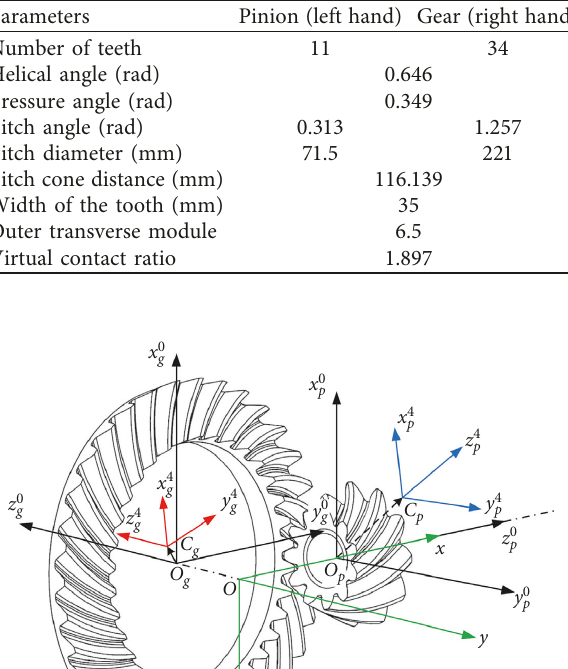
Table 1: Design parameters of the example spiral bevel gear pair. Parameters